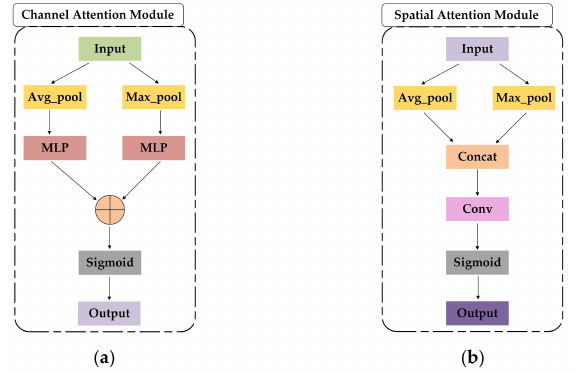
Figure 5. Schematic diagram of channel attention module and spatial attention module. ( a ) Channel attention module, where ⊕ represents summation operation. ( b ) Spatial attention module, which is given the output of the channel attention module as the